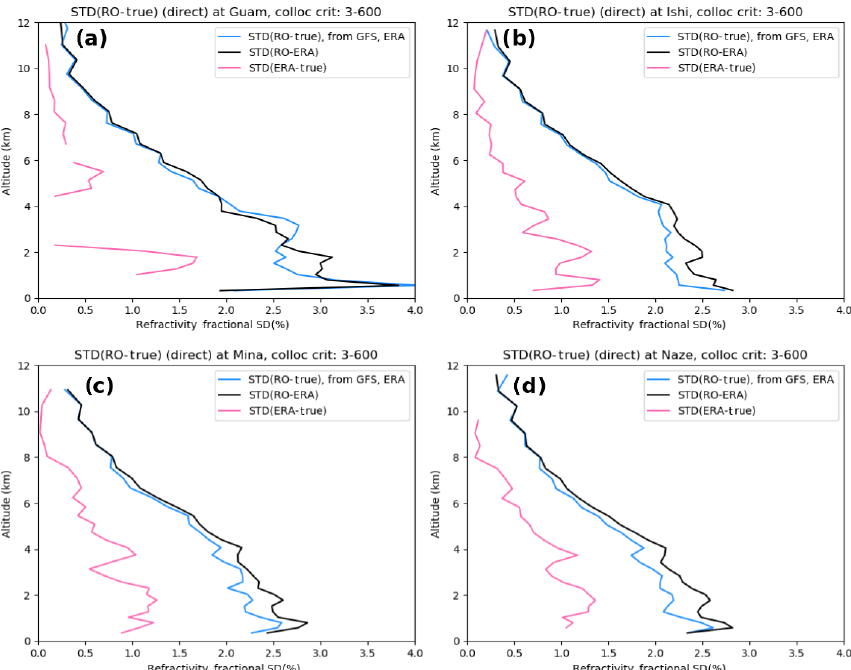
Figure 5. Standard deviations of the apparent-error SD(RO–ERA) (black line), estimated RO error SD(RO–true) computed from Eq. (7) (blue line) and ERA error SD(ERA–true) (pink line) for refractivity at (a) Guam, (b) Ishi, (c) Mina, and (d)